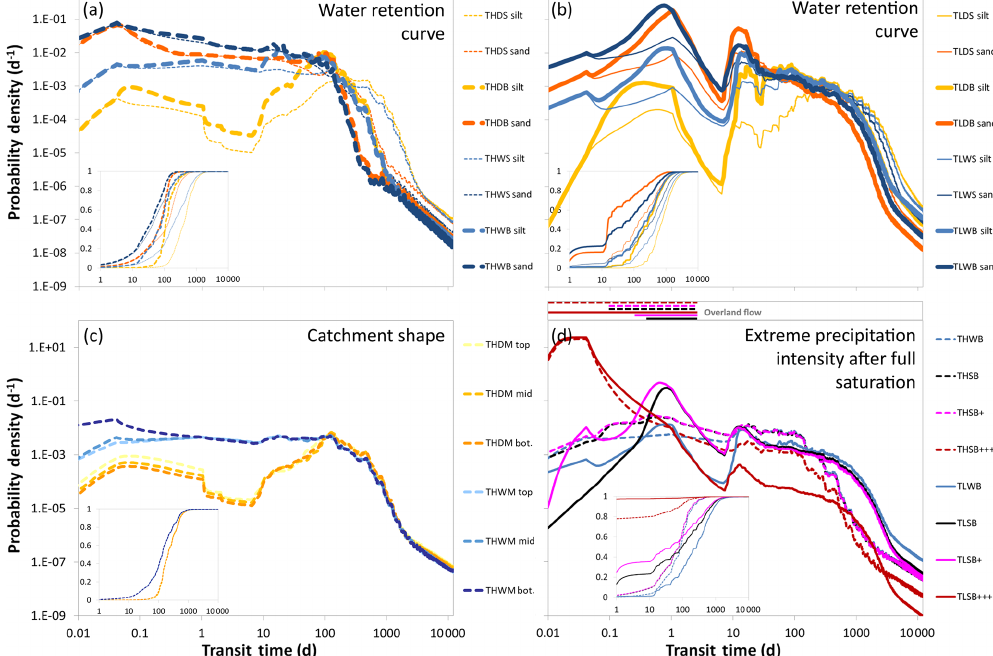
Figure 13. Overview of how certain catchment and climate characteristics influence the shape of TTDs (continued). Panels (a–b) : Water retention curves (WRCs) – light blue and yellow lines indicate silt-type soil WRCs, dark blue and orange lines indicate sand-type soil WRCs. (a) Scenarios with high K S , (b) scenarios with low K S . (c) Catchment shape – lighter shades of a color indicate top-heavy, darker shades bottom-heavy catchments. (d) Full saturation and extreme precipitation – black lines indicate fully saturated initial conditions, pink lines fully saturated initial conditions and very large event precipitation ( + ), red lines fully saturated initial conditions and extreme event precipitation ( +++ ). The horizontal lines in the box above the diagram indicate periods where actual overland flow was recorded during the respective runs. The insets show the cumulative TTDs.